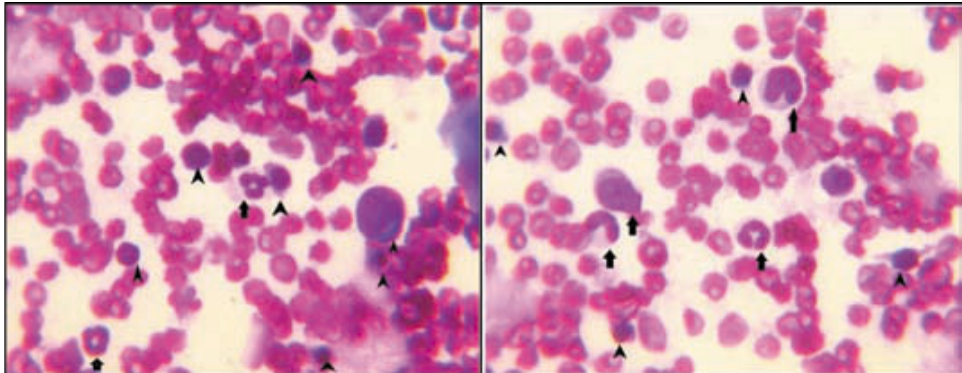
Fig. 6. Bone marrow smear, 1000 X magnification, Field stain. Arrow head indicate cells of erythroid series and arrows indicate cells of myeloid